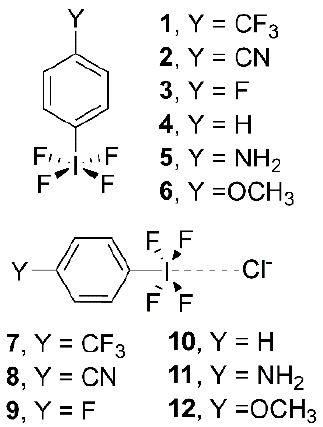
Figure 1. Compounds and Complexes 1 – 12 studied in this work.